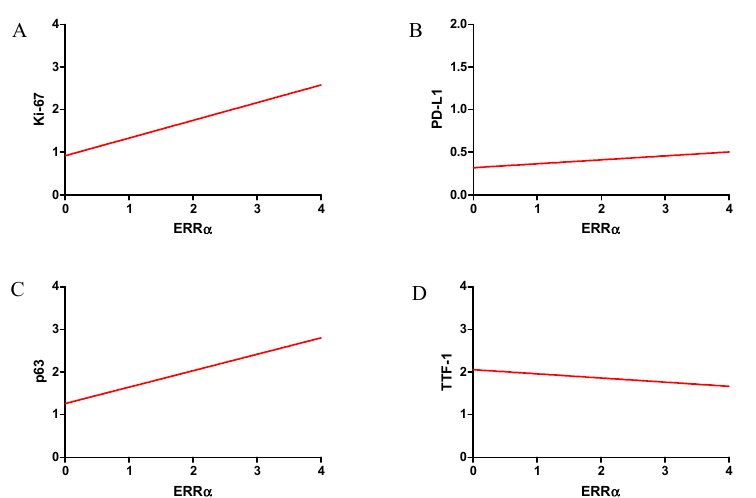
Figure 6. Correlations of ERR α receptor expression levels with diagnostic markers were strong positive—Ki-67 ( A ), moderate positive—EGFR ( B ), moderate positive—p63 ( C ) and weak positive—PD-L1 ( D ) in NSCLC (n = 860).